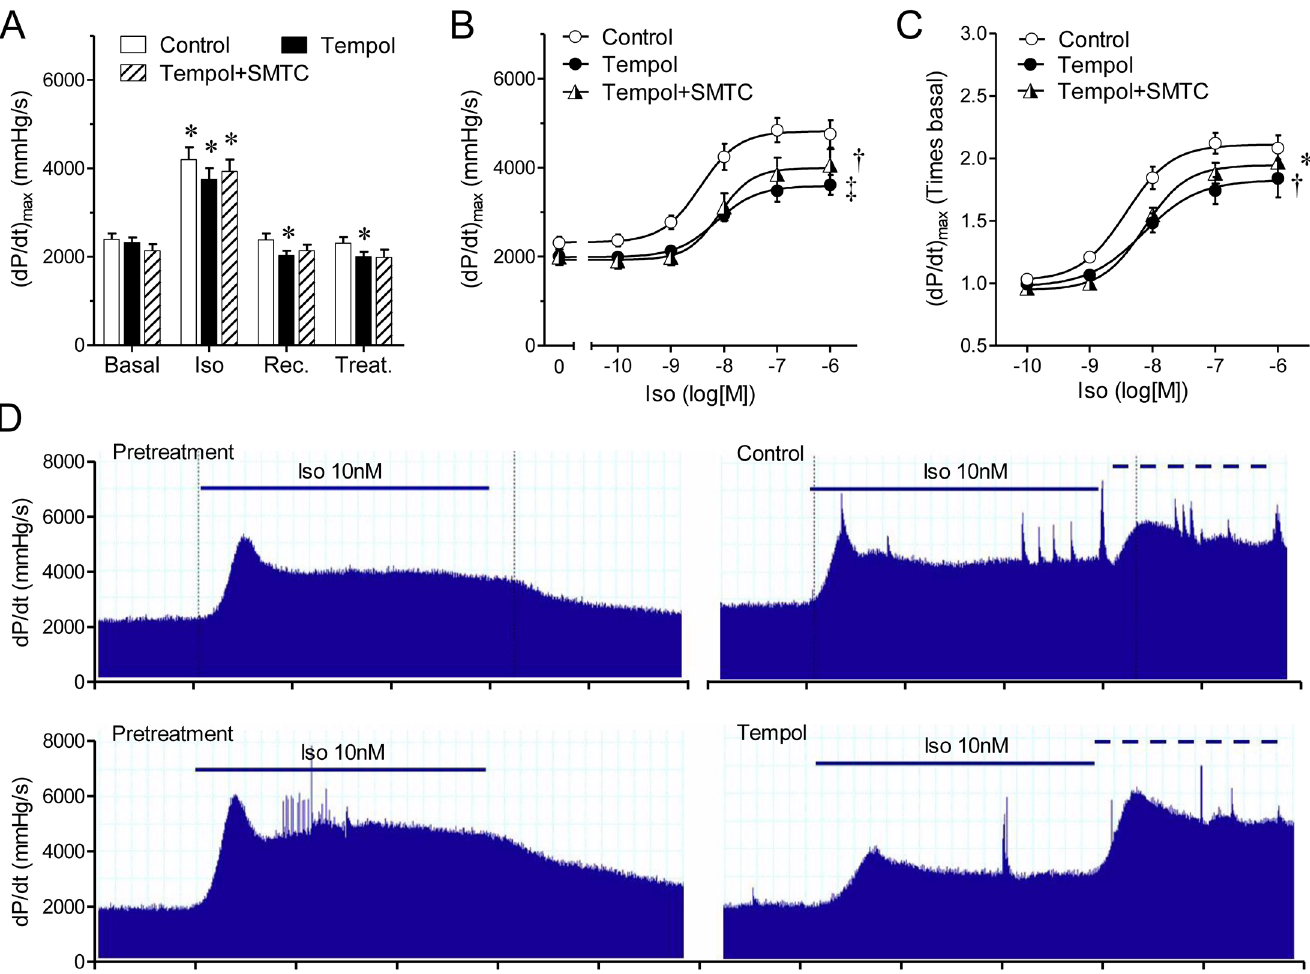
Fig 7. Inhibition of the nitrosylation reaction with tempol, a radical scavenger, reduces the inotropic response to β -adrenergic stimulation. (A) Contractility (dP/dt max ) determined consecutively under basal conditions (Basal), isoproterenol stimulation (Iso); recovery (Rec.), and treatment (Treat.) with vehicle (Control, n = 12), tempol 100 μ M (Tempol, n = 9), or tempol 100 μ M plus NOS-1 inhibitor SMTC 300nM (Tempol+SMTC, n = 6), details as in Fig 1. Asterisk indicates p < 0.05 vs. Basal (paired t test, with Dunnett ’ s modification). (B) Concentration-response curves to isoproterenol alone (Control), in the presence of tempol, and tempol plus SMTC. (C) Same data as in panel B, expressed as relative values, corrected by the corresponding contractility values after treatment with inhibitor or inhibitors. * p < 0.05, † p < 0.01, ‡ p < 0.001 vs. Control curve (Best fit ANOVA, the difference resided only in the top value; bottom and EC 50 parameters were shared). (D) Representative records showing contractility changes (dP/dt) elicited by the application of Iso10nM (solid line) before and after treatment (control or tempol). The dashed line indicates application of 100nM Iso as part of the dose-response